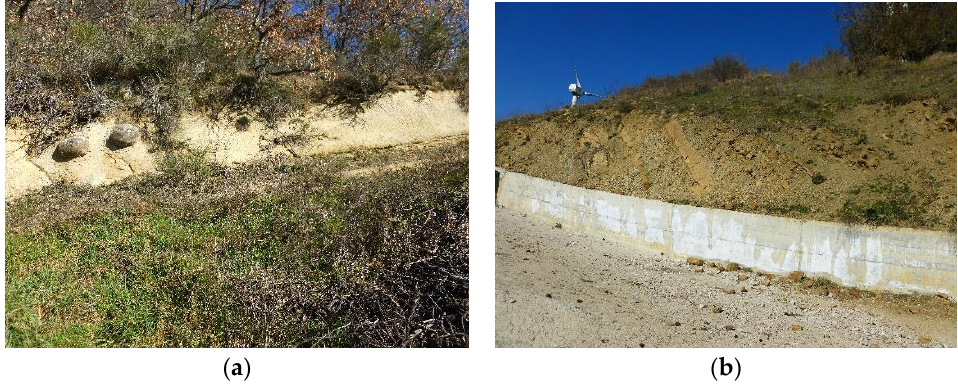
Figure 5. Pre-Quaternary bedrock: ( a ) outcrop the Gorgoglione Formation; ( b ) outcrop the Albidona Formation. The site where the photos were taken is reported in Figure 4. (Photoes taken by Bentivenga M.)